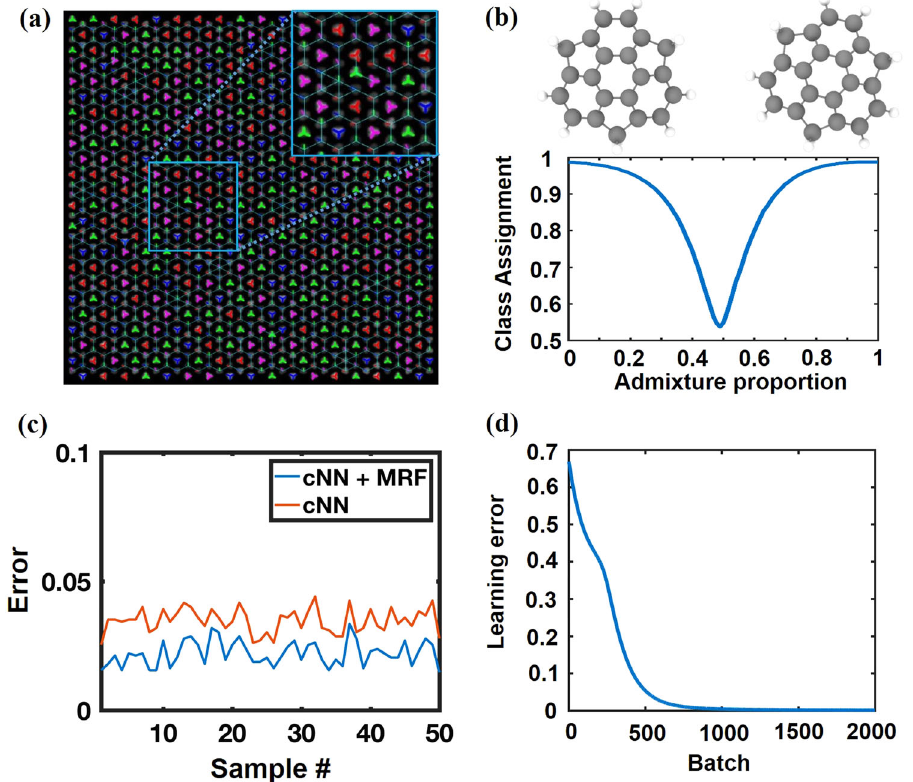
classi fi ed via MRF prior to applying cNN). b The dependency of cNN accuracy (probability of a correct state assignment) on the admixed proportion of a different rotational state. The two rotational cases considered are shown at the top of the image c Comparison of error rate for cNN only and cNN + MRF approaches. d cNN learning error